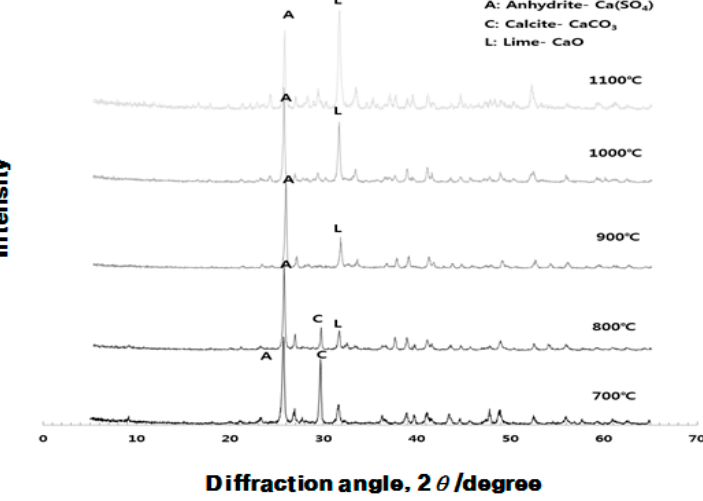
Figure 11. Quantitative analysis of the crystal structure of ESA at different burning temperatures.